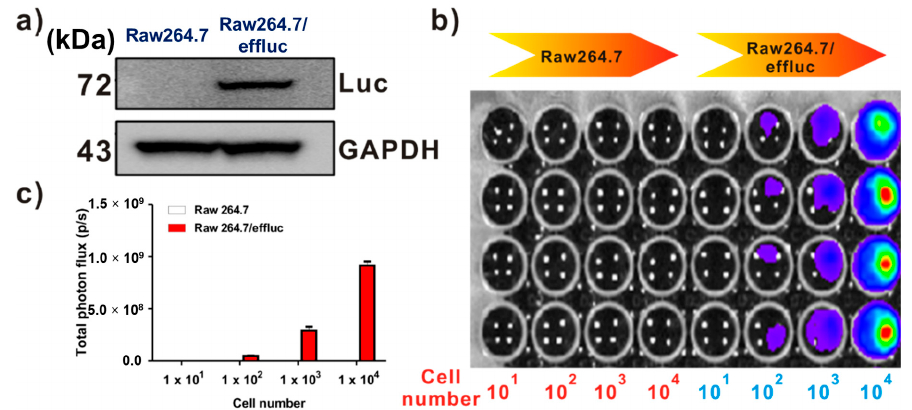
Figure 2. Expression of the enhanced firefly luciferase (effluc) gene as an optical reporter gene in Raw264.7 cells. ( a ) Western blot analysis showing the luciferase protein expression with